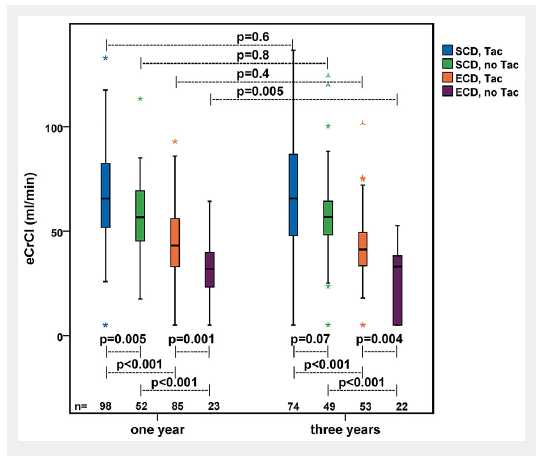
Renal function at one-year and three-year follow-up stratified by donor status and type of immunosuppression. An eCrCl of 5ml/min was assumed in patients who suffered from graft failure before the defined follow-up time points (one year n = 10 and three years n = 18); p-values of differences between groups were calculated by Mann-Whitney test; p-values of differences between one-year and three-year follow-up were calculated by Wilcoxon signed-rank test, considering only patients with values at one year and three year follow-up (n = 198). ECD = expanded-criteria donor; eCrCl = estimated creatinine clearance in accordance with the formula by Cockcroft and Gault [33]; SCD = standard-criteria donor; Tac =